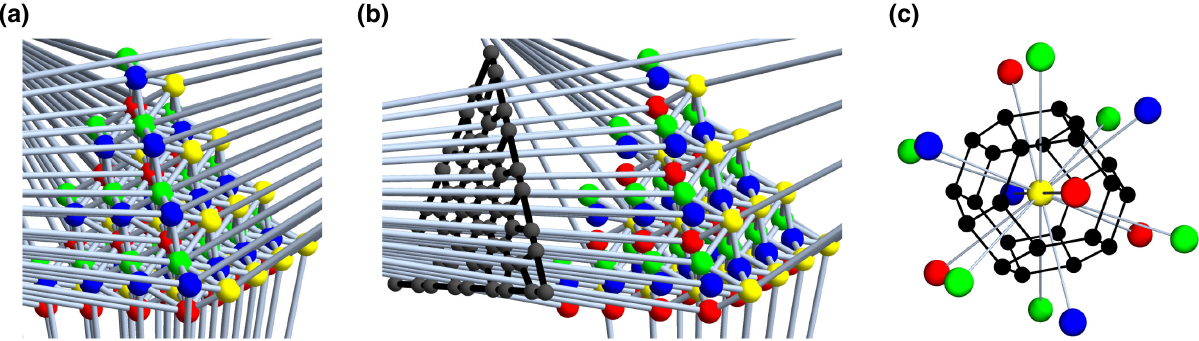
FIG. 25. (a) In one gauge fixing of the 3D subsystem color code G sub on the lattice L 3D [shown in Fig. 5(b)], all Z edges (depicted by light struts) are satisfied. This corresponds to the 3D stabilizer color code S 3D . (b) In another gauge fixing of G sub , all X and Z edges incident to Y vertices in (cid:8) 0 ( L 3D ) (depicted by light struts) are satisfied. This corresponds to the 2D color code S 2D on the qubits near the boundary vertex v Y and the 2D spherical color codes S int on other qubits. We depict the primal lattice of the 2D color code on the lattice L 2D [shown in Fig. 5(a)] in black. (c) Around each Y vertex in (cid:8) (cid:19) lattice we depict in